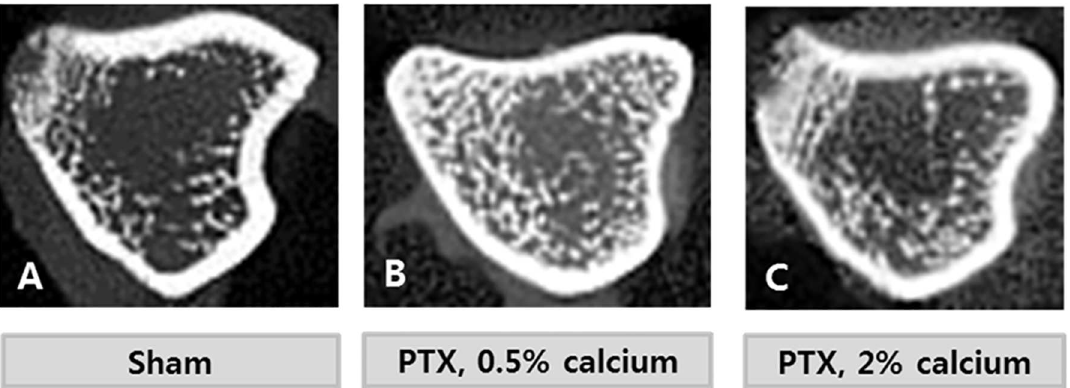
Fig 7. Microcomputerized tomographic images of tibia. Axial images of scans demonstrated that the trabecular bones, that display as white lines, were denser in the PTX groups than SHAM